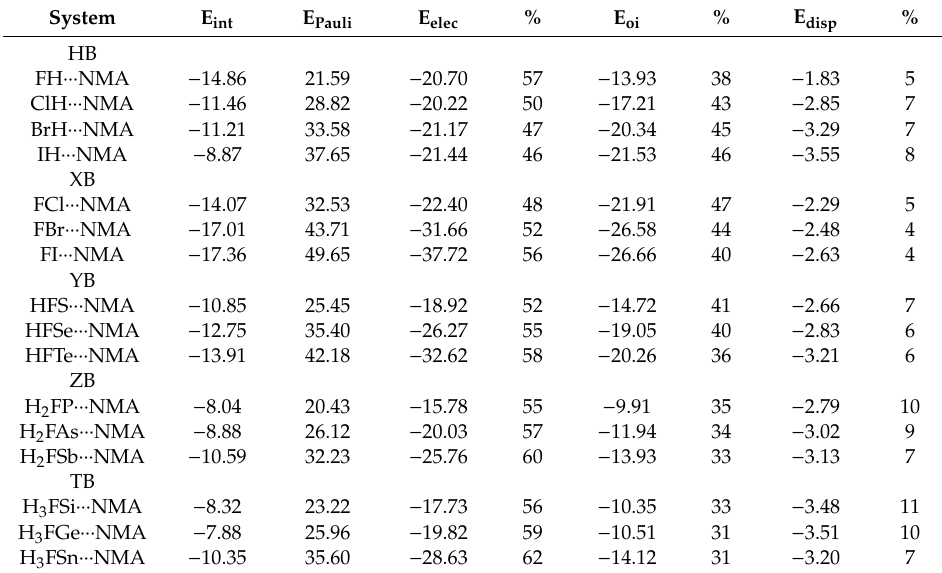
Table 5. EDA / BLYP-D3 / ZORA / TZ2P decomposition of the interaction energy of complexes into Pauli repulsion (E Pauli ), electrostatic (E elec ), orbital interaction (E oi ), and dispersion (E disp ) terms. All energies are in kcal / mol. The relative values in percent express the contribution of each to the sum of all attractive energy terms. Geometries are taken from MP2